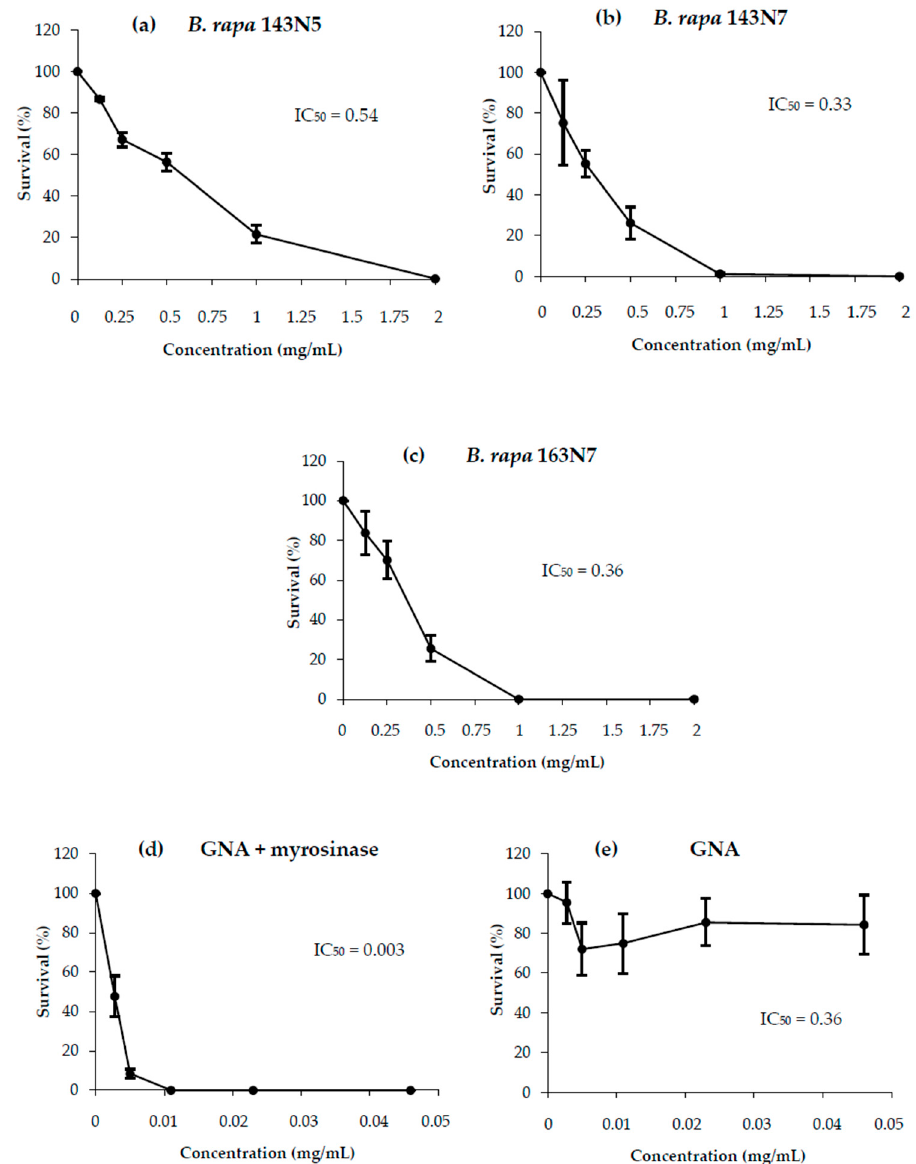
Figure 3. Survival of HL-60 cultures treated with different concentrations of: B. rapa ( a ) 143N5, ( b ) 143N7 and ( c ) 163N7 plant material; bioactive compound: ( d ) hydrolyzed gluconapin and ( e ) gluconapin. Survival curves are plotted as percentages with respect to the control counted at 72 h treatment from at least three independent experiments (mean ± SE).